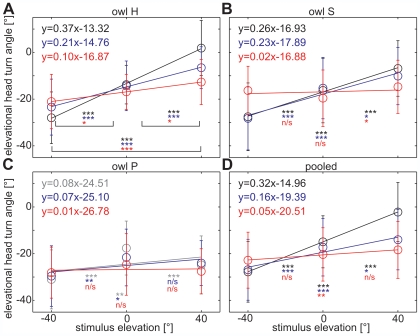
Elevational head-turn angles.The elevational head-turn angles (mean±SD) are plotted against stimulus angles for (A–C) owls H, S, and P individually as well as (D) the pooled data from all owls. Since the owls reacted to stimulus elevation even with individualized HRTFs only in the frontal area, stimulus angles of <±60° were included. With individualized HRTFs (A,B, black line and circles), there was a significant increase in the elevational turning angle with stimulus elevation (Mann-Whitney test, p<0.001). The slope of this increase was lower, but still significant with non-individualized HRTFs of owl 39 normal (blue). In the ruffcut condition (red), the slope was significantly different from 0 only for owl H, but neither for owl S nor for owl P. Owl P reacted similar to non-individualized HRTFs (gray: owl H's HRTFs, blue: owl 39 normal) as the other two owls, but located stimuli at 40° elevation lower than those at 0° elevation. However, the general characteristics of the elevational head-turn behavior were preserved in that the increase of head-turn angle with stimulus elevation was strongly reduced in the ruffcut condition for all owls compared to HRTFs recorded with intact ruff (D). The linear equations are given for each stimulus condition. For each pair of stimulus angles (−40° and 0°, 0° and 40°, and −40° and 40°), head-turn angles were compared with a Mann-Whitney test; significant differences are marked with asterisks (***p<0.001, **p<0.01, *p<0.05). Each data point includes at least 18 trials.